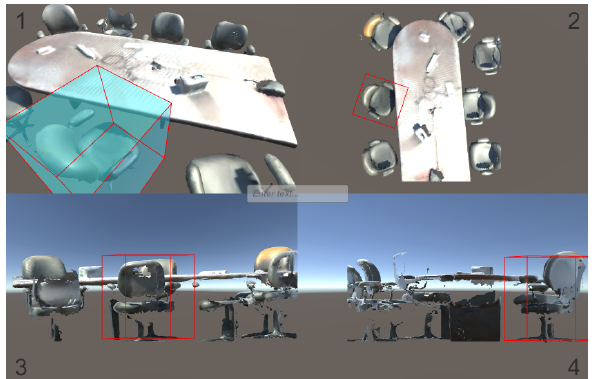
Figure 8: A screenshot from our replica of the SUN RGB-D an- notation tool displaying environment 1. Top left: an arbitrary perspective view. Top right: bird’s eye view. Bottom left and right: orthogonal side views.